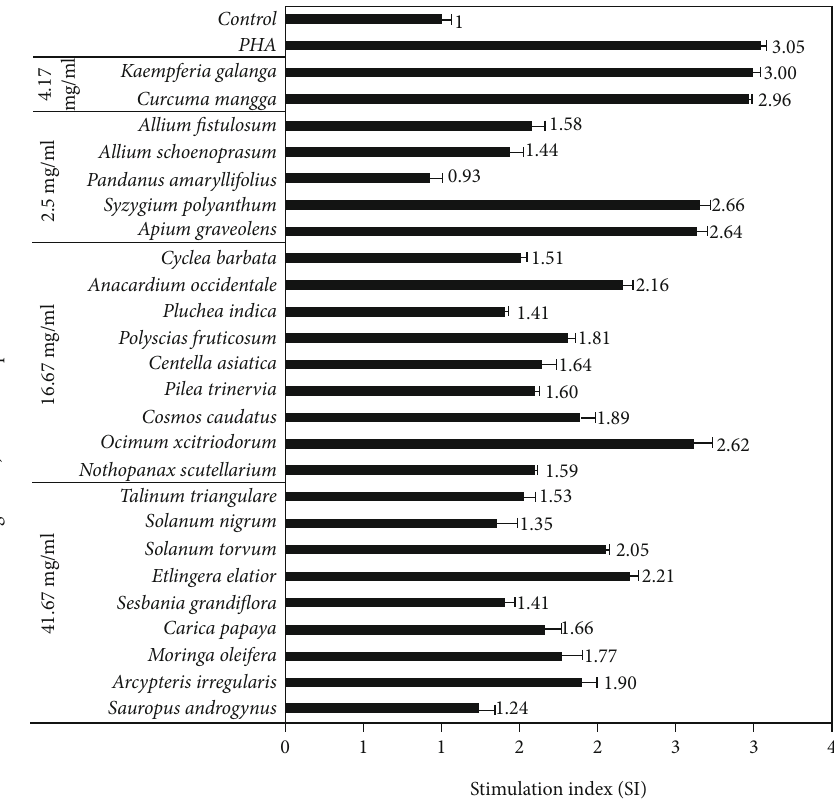
Figure 1: The e ff ect of 25 select vegetable, herb, and spice extracts on human peripheral lymphocyte proliferation in vitro ( n = 3 , error bars represent standard